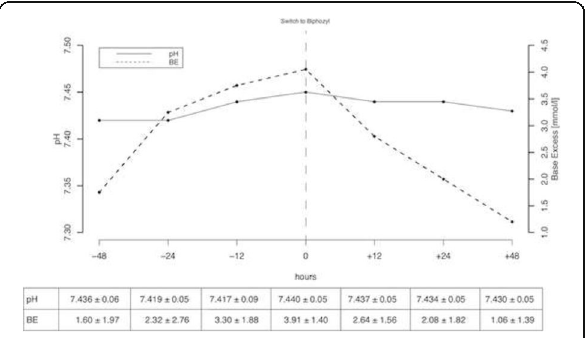
Fig. 1 (abstract 0303). Time course of pH and base excess (BE)